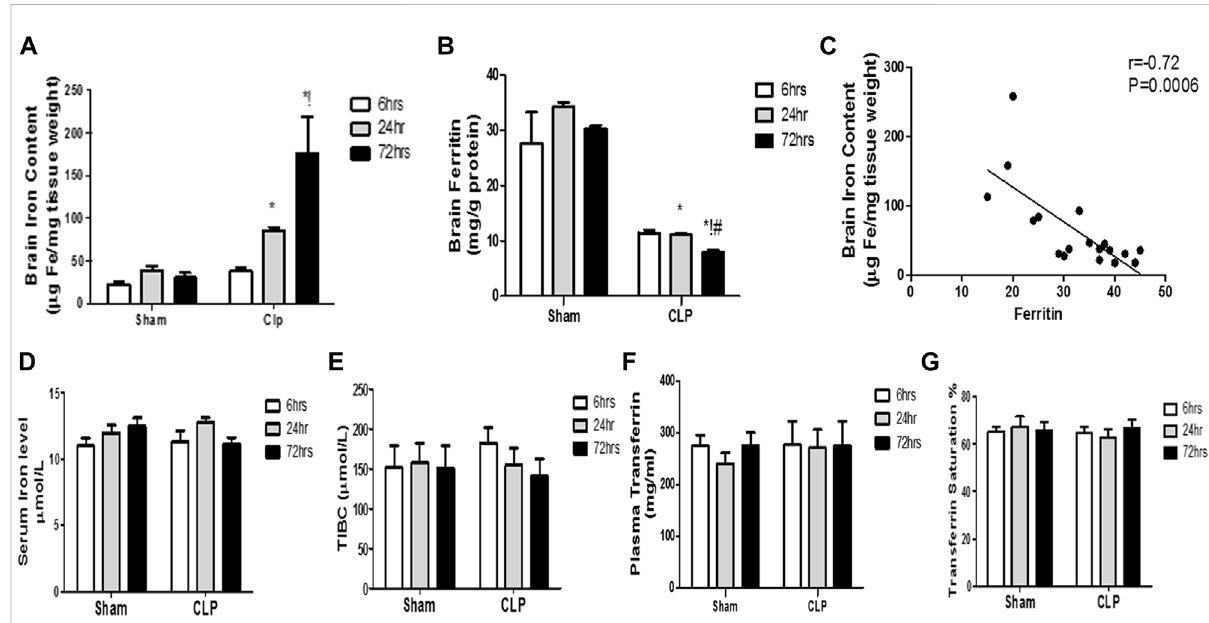
FIGURE 8 Changes in serum transferrin and brain ferritin over time during sepsis. The quantitative analysis of brain ferritin (A) and serum transferrin (B) showedasigni fi cantdecreaseinbrainferritinlevel,butnotinserumtransferrin,at24and72 haftersepsis. (C) Pearson ’ scorrelationanalysisbetween ironlevelinthebrainandferritinlevel.Theserumironlevel (D) ,thetotalironbindingcapacity(TIBC) (E) ,theplasmatransferrin (F) ,andthepercentage oftransferrinsaturation (G) arenotsigni fi cantlydifferentbetweenthesham-andCLP-operatedgroups.Dataarethemeans±SEM.* p < 0.05vs. the corresponding sham group; ! p < 0.05 vs. the 6-h CLP group; # p < 0.05 vs. the 24-h CLP group. N = 10 rats per group.